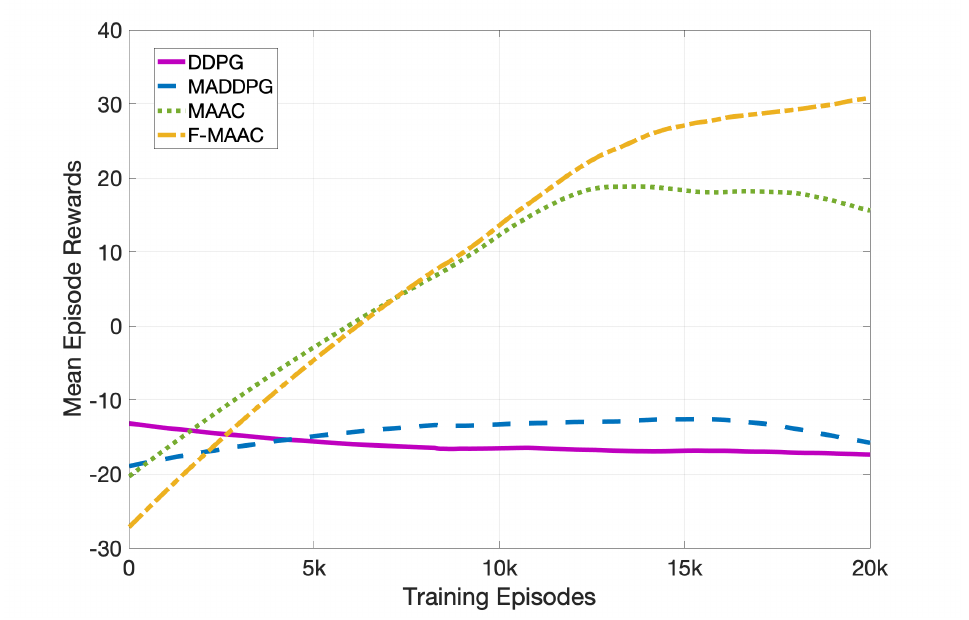
Figure 9. Mean episode rewards comparison of different models for 20k episodes.